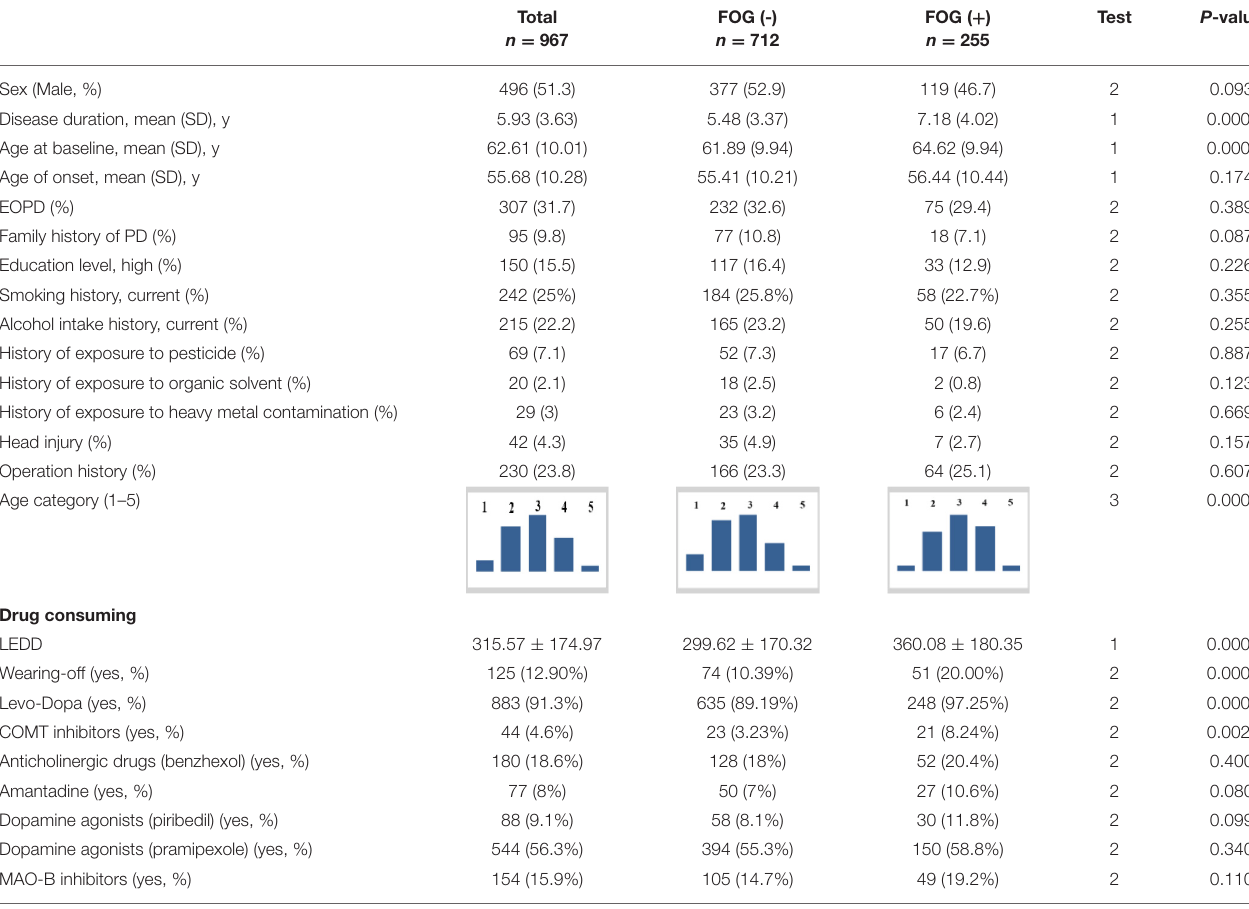
TABLE 1 | Baseline characteristics of demographic and drug consuming of the